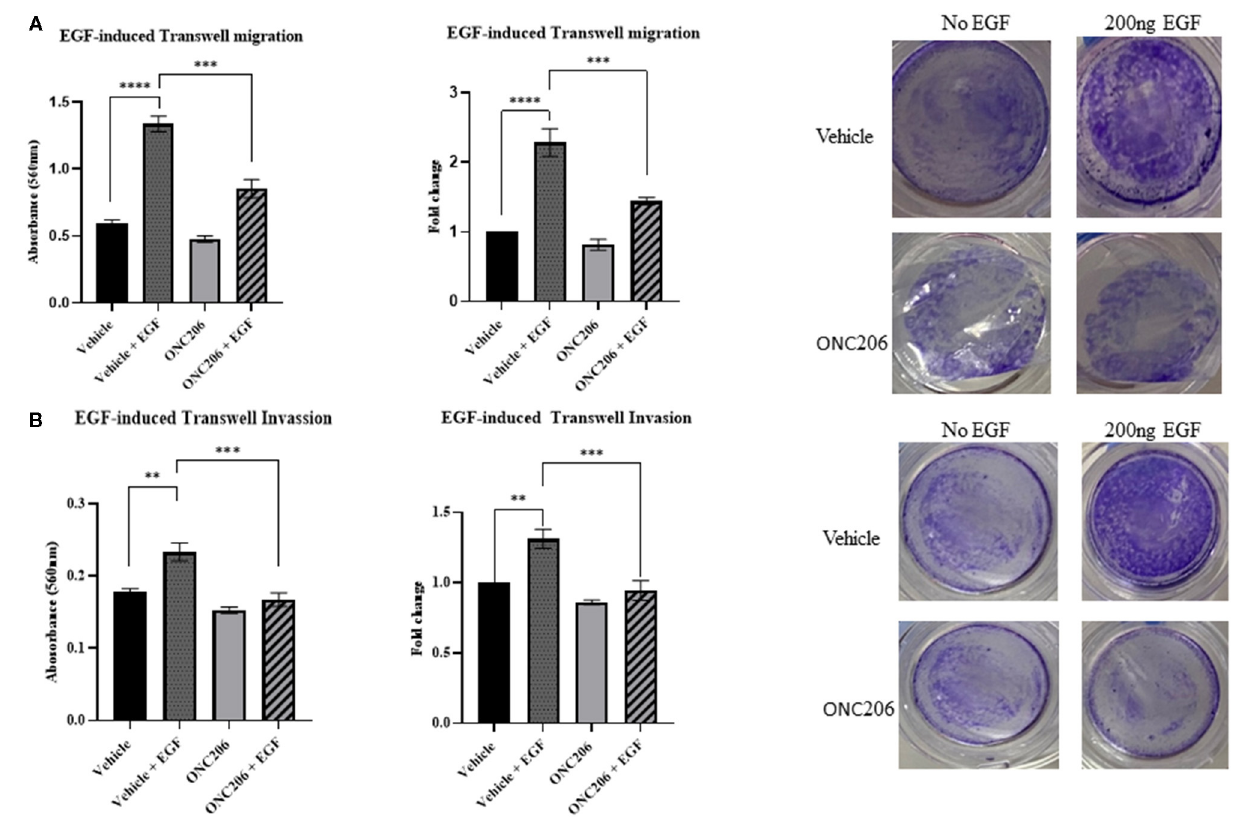
FIGURE 4 | EGF-induced cellular trans-well migration and invasion inhibited with ONC206 treatment. IMR-32 cells treated with ONC206 (1 µ M) exhibited a significant reduction in the EGF-induced cellular migration (A) and invasion (B) through the ECM-coated trans-well chambers compared with vehicle-treated cells. Experiments were conducted in triplicates and repeated three times. Data represent the mean ± the standard error of the mean (SEM) of multiple experiments. ** p < 0.01; *** p < 0.001; **** p <